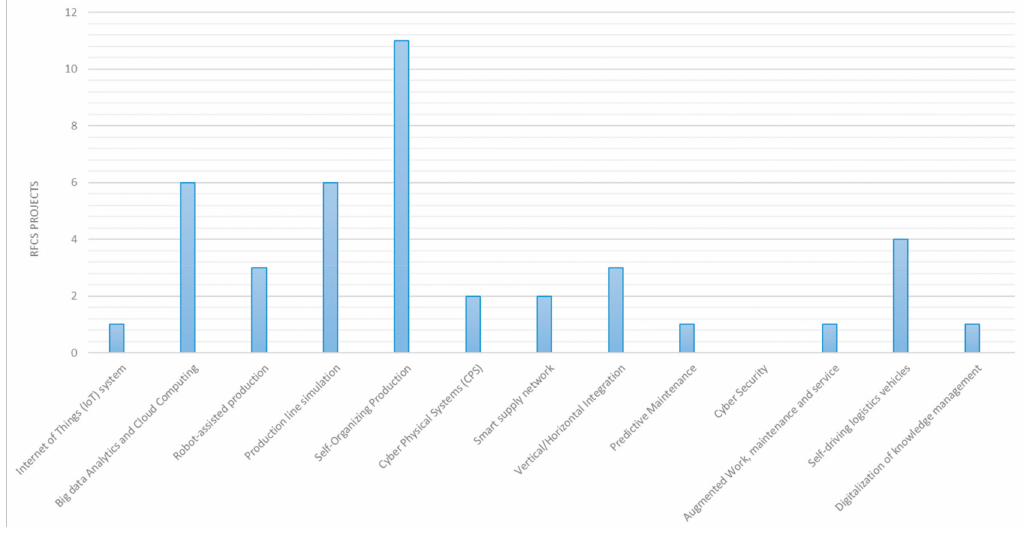
Figure 2. Number of RFCS projects by enabling